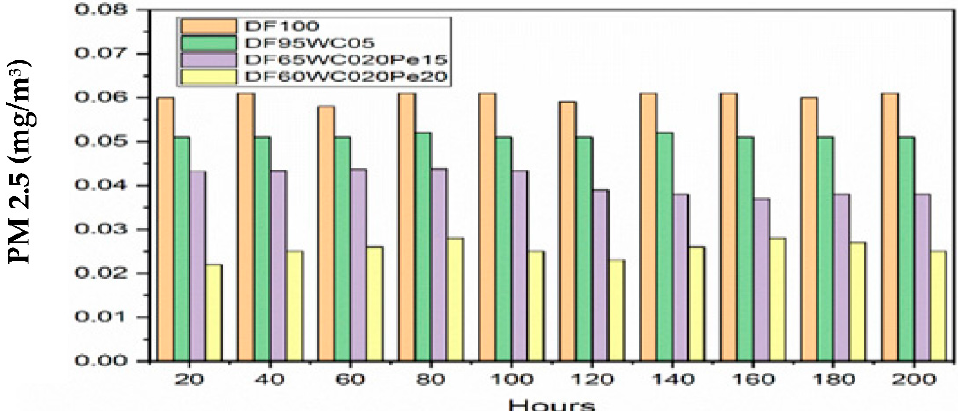
Figure 8. Particulate emission 2.5 (ppm) versus engine running hours.